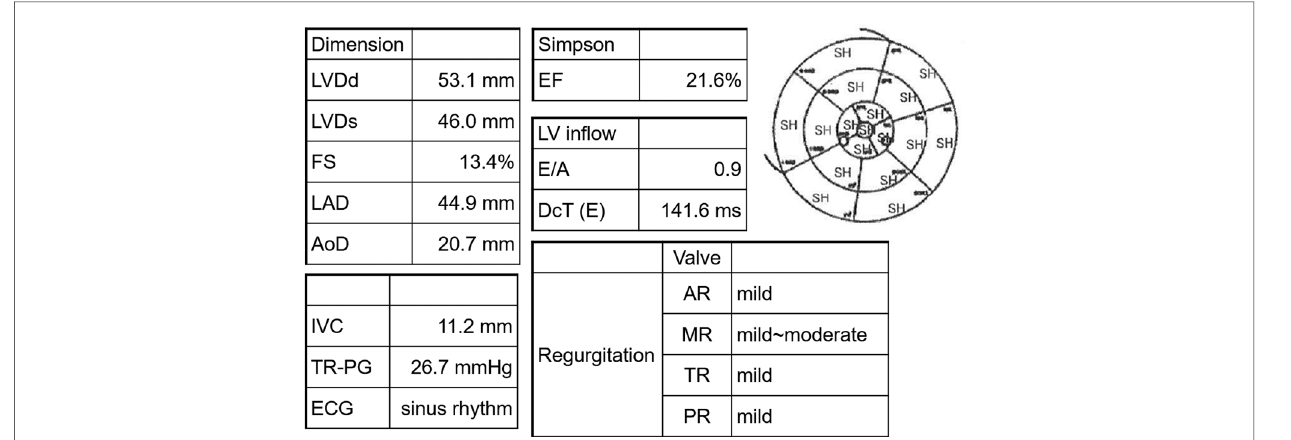
FIGURE 1 Transthoracic echocardiogram fi ndings at the emergency department visit. LVDd, left ventricular internal dimension in diastole; LVDs, left ventricular internal dimensions in systole; FS, fractional shortening; LAD, left atrial dimension; AoD, aortic root diameter; IVC, inferior vena cava; TR-PG, tricuspid